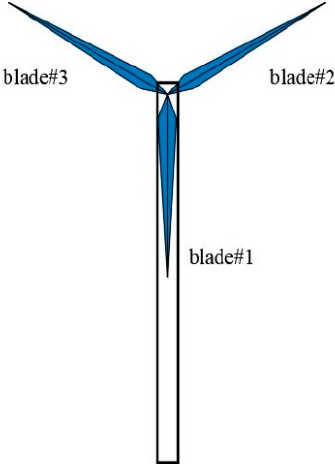
Figure 11. Blade position ( ψ = 60°).